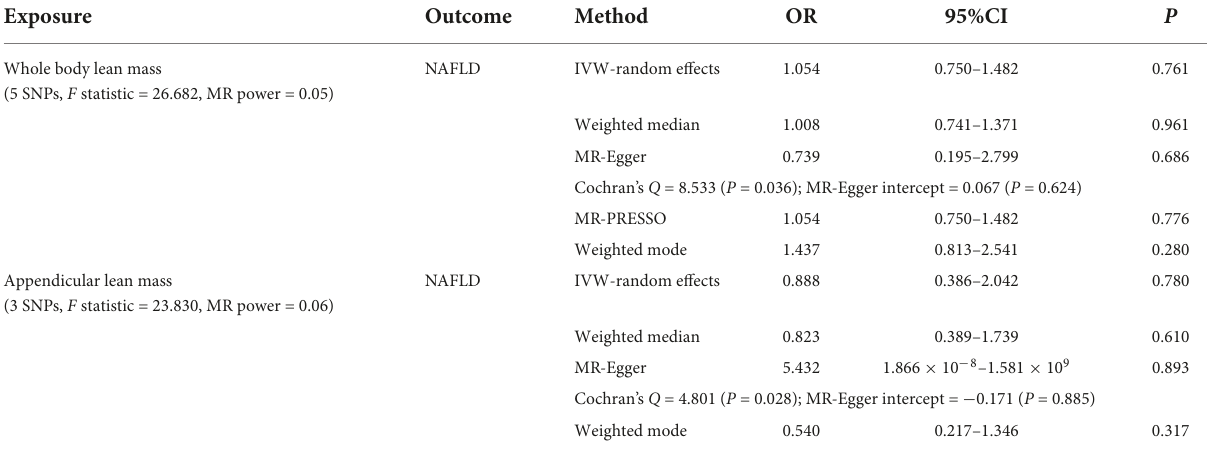
TABLE 2 MR estimates from different methods assessing the causal effect of lean body mass on NAFLD. Exposure